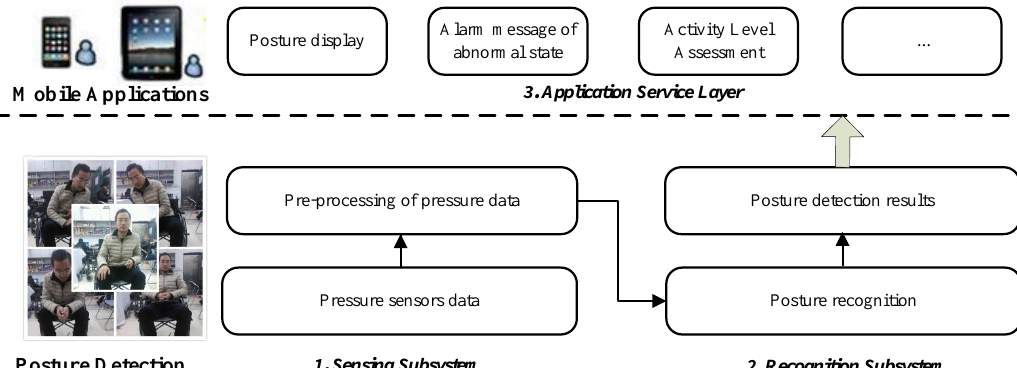
Figure 1. Architecture of the proposed